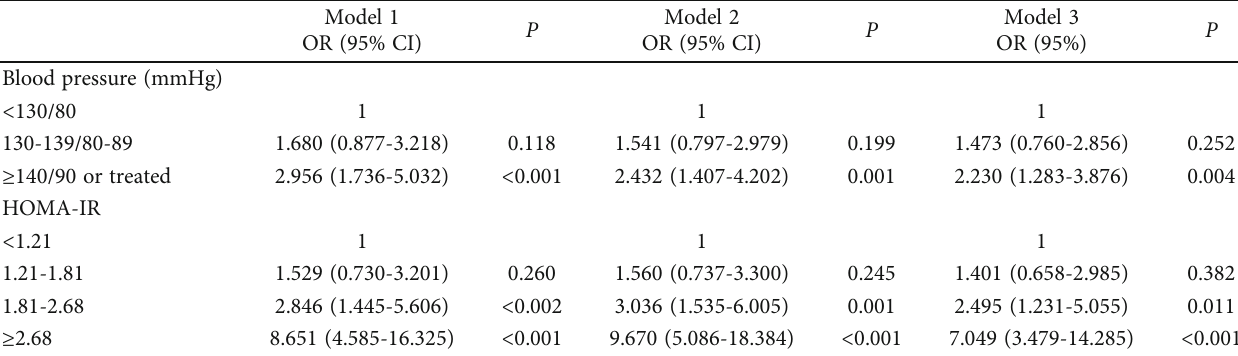
Table 2: The odds ratio (OR) of new-onset diabetes with di ff erent BP and HOMA-IR levels [OR (95%